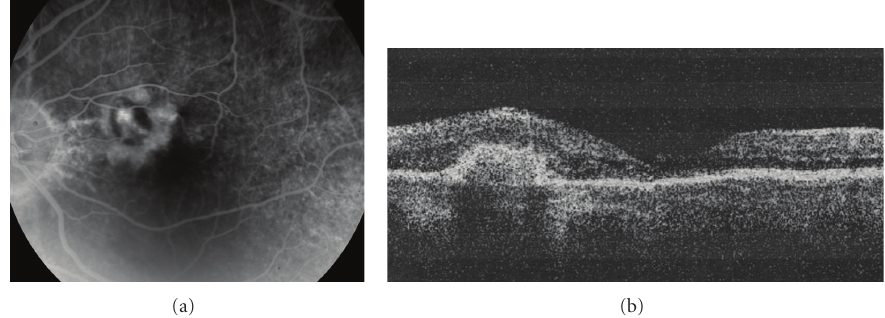
Figure 2: Images of the left eye after a 5-month loss to follow-up (the visual acuity was finger counting). (a) Fluorescein angiography shows an active CNVM. (b) Optical coherence tomography shows a parafoveal CNVM and mild intraretinal fluid.